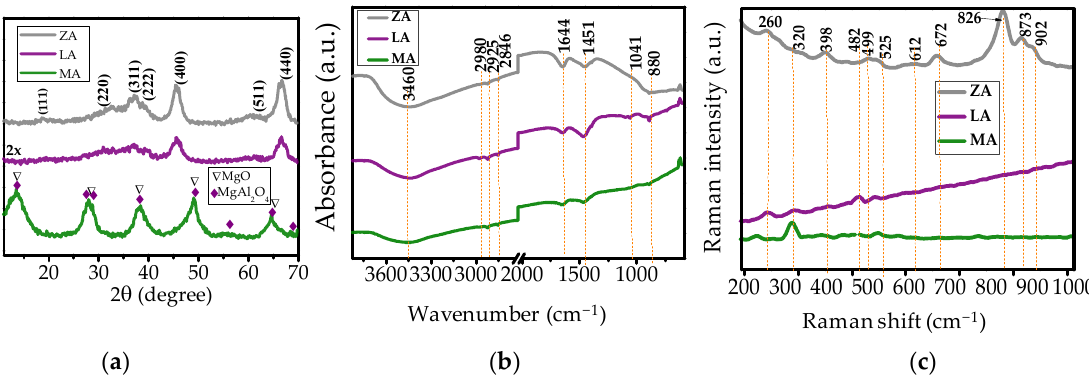
Figure 2. Physicochemical characterizations of the supports: ( a ) XRD, ( b ) FTIR and ( c ) Raman measurements. The letters LA, ZA, MA represent the La 2 O 3 –Al 2 O 3 , ZnO–Al 2 O 3 and MgO–Al 2 O 3 supports, respectively. The XRD pattern of LA sample is amplified 2× in Figure 2a.